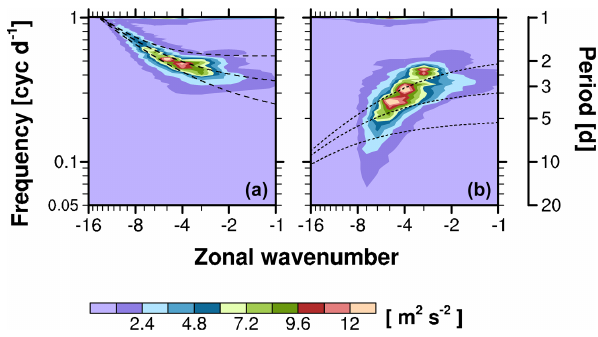
Figure 14. The same as in the rightmost panel of the first row in Fig. 2 (JRA-55C, at 20hPa) except for the averages over the months when (a) the radiosonde-observed zonal wind U < − 25ms − 1 and (b) U > − 20ms − 1 . The dashed lines in panel (a) indicate the MRG wave dispersion curves for h = 8, 60, and 480m for the background wind of − 30ms − 1 , and the dotted lines in panel (b) indicate those for the windless background